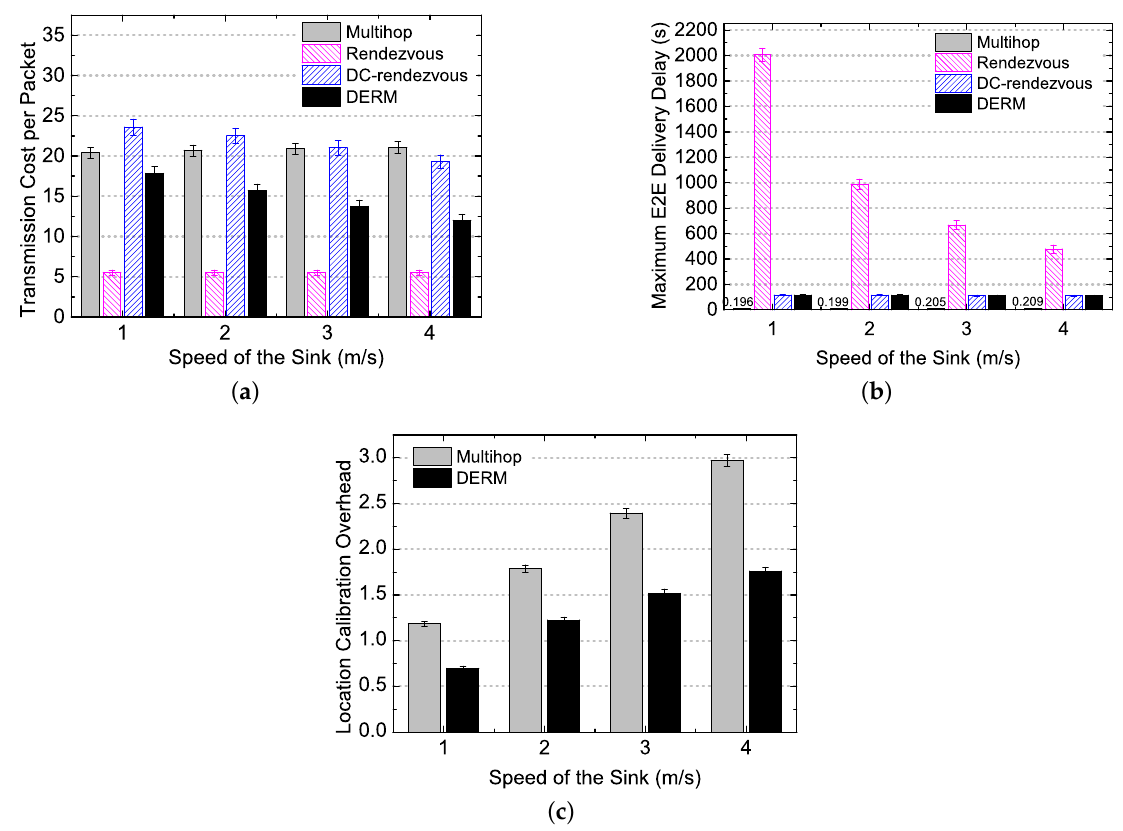
Figure 10. Performance overview under different sink speeds in realistic movement scenarios ( D s = 120 s, α = 1.2, and the pause time is 30 s). ( a ) transmission cost per packet; ( b ) maximum end-to-end delivery delay; ( c ) location calibration